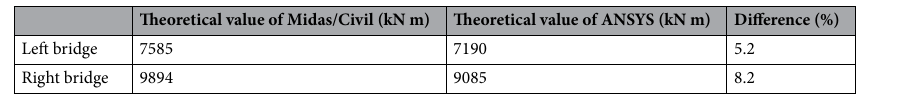
Table 2. Lateral unbalanced moment of two models. Difference = (D Midas − D ANSYS )/D Midas